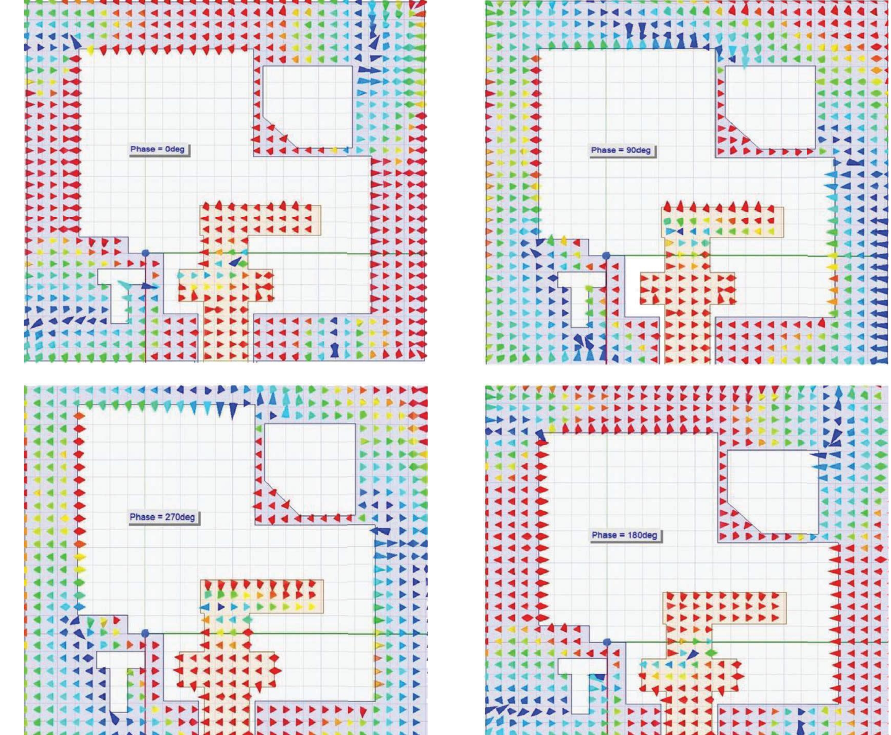
Figure 7: Circular polarization at